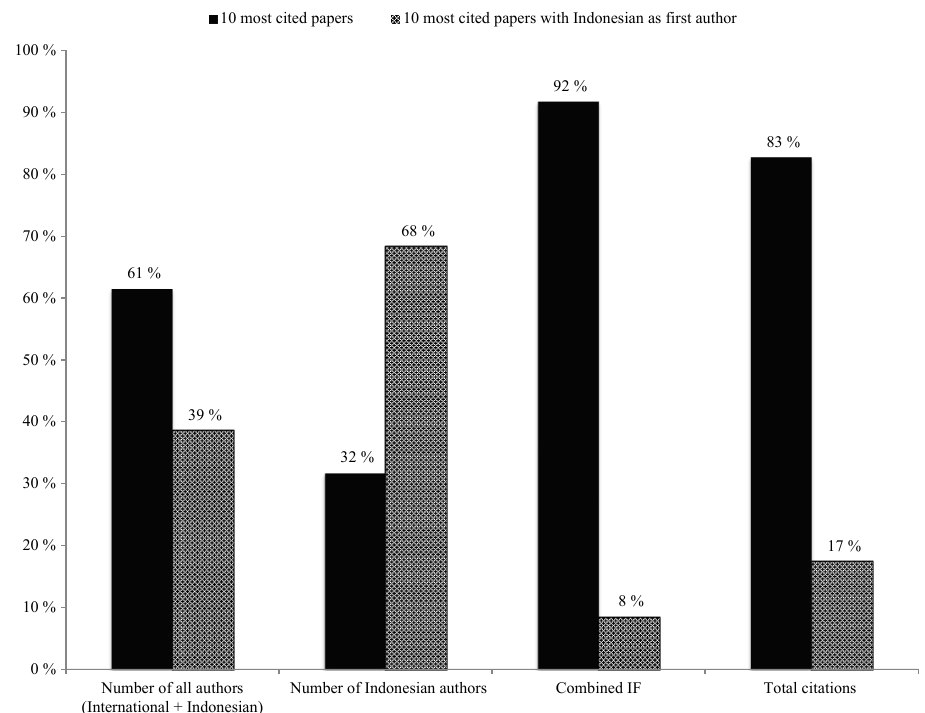
Figure 7. Comparing the roles of Indonesian researchers in the 10 most cited